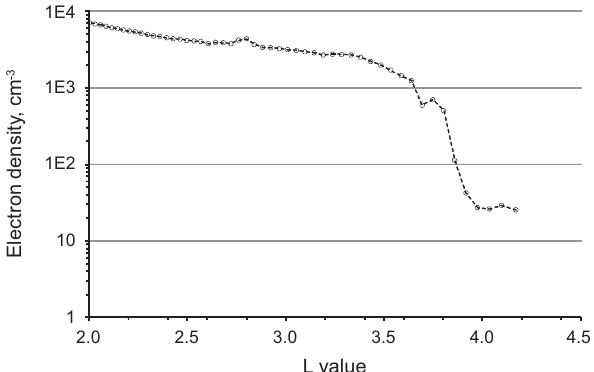
Fig. 4. GPS TEC-derived electron density profile for 1400 UT, 16